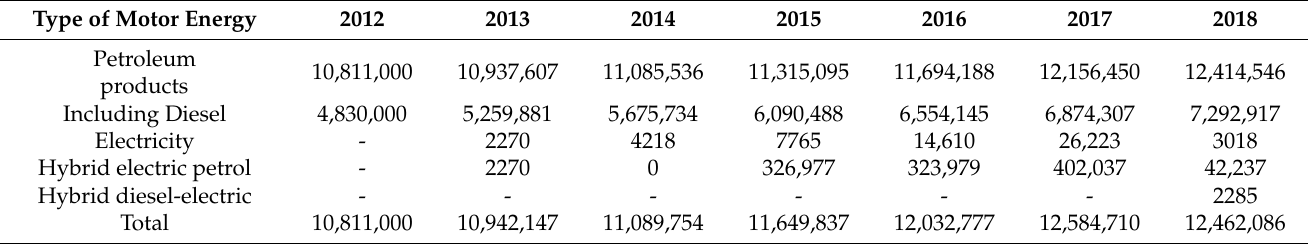
Table 1. Types of motor energy in passenger cars in 2012–2018 in Poland